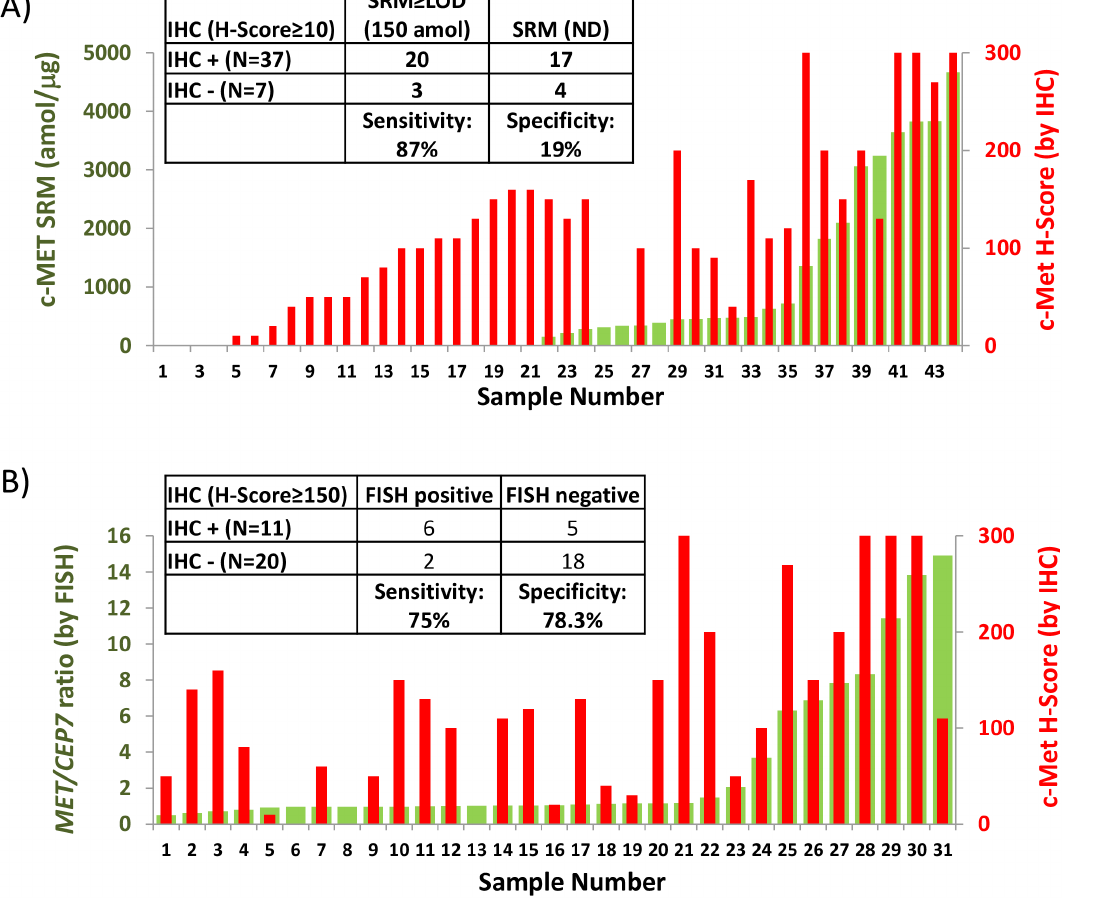
Figure 8. IHC to SRM or FISH a ssay correlations. Correlation of IHC Met positive H-score to (A) Met SRM (amol/ m g) or (B) MET/CEP7 ratio by FISH. Inset tables assess sensitivity/specificity of IHC H-score, assuming SRM (A) and FISH (B) as the comparative standards.